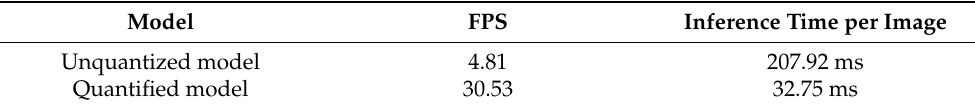
Table 6. Comparison of YOLO-GD inference times without and with quantification on Jetson Nano.